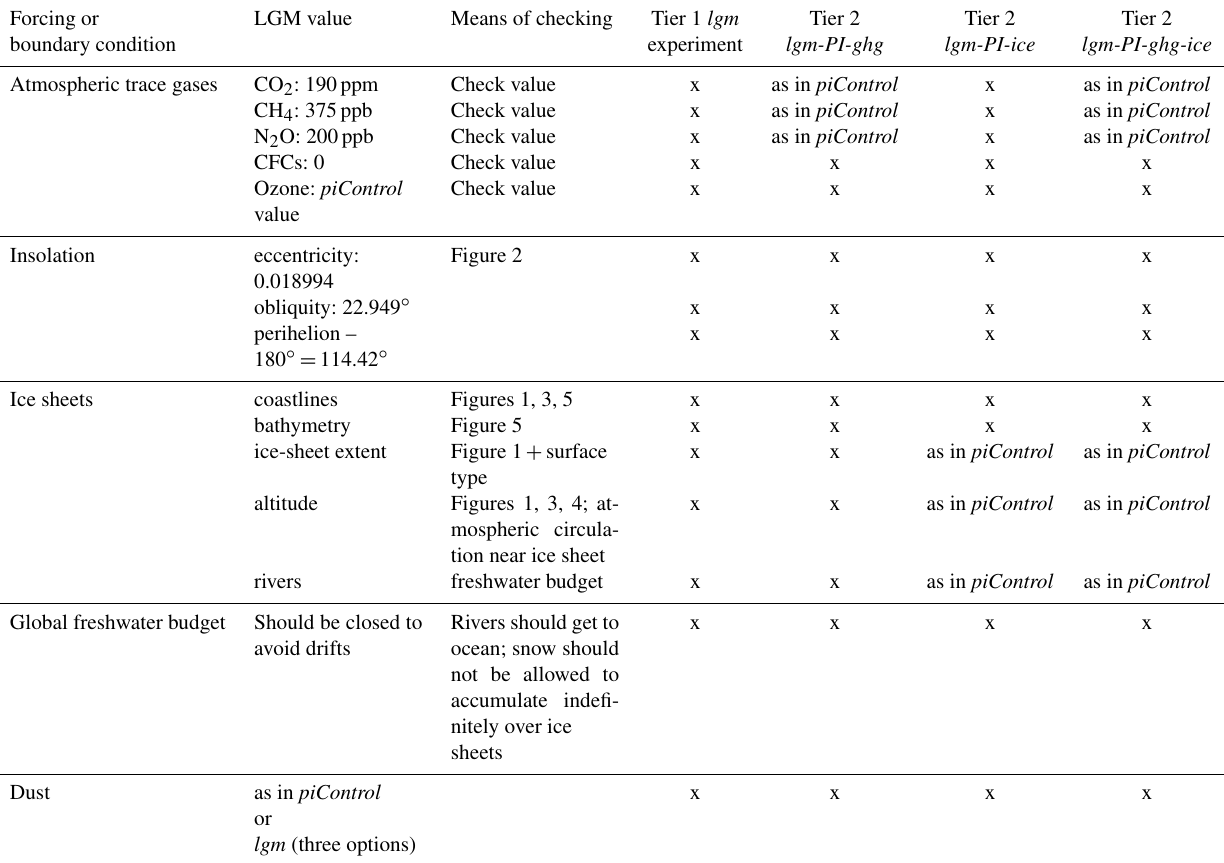
Table 1. Summary of the forcings and boundary conditions for the Tier 1 lgm experiment and the Tier 2 sensitivity experiments. This table also provides a summary of checking points for these forcings and boundary